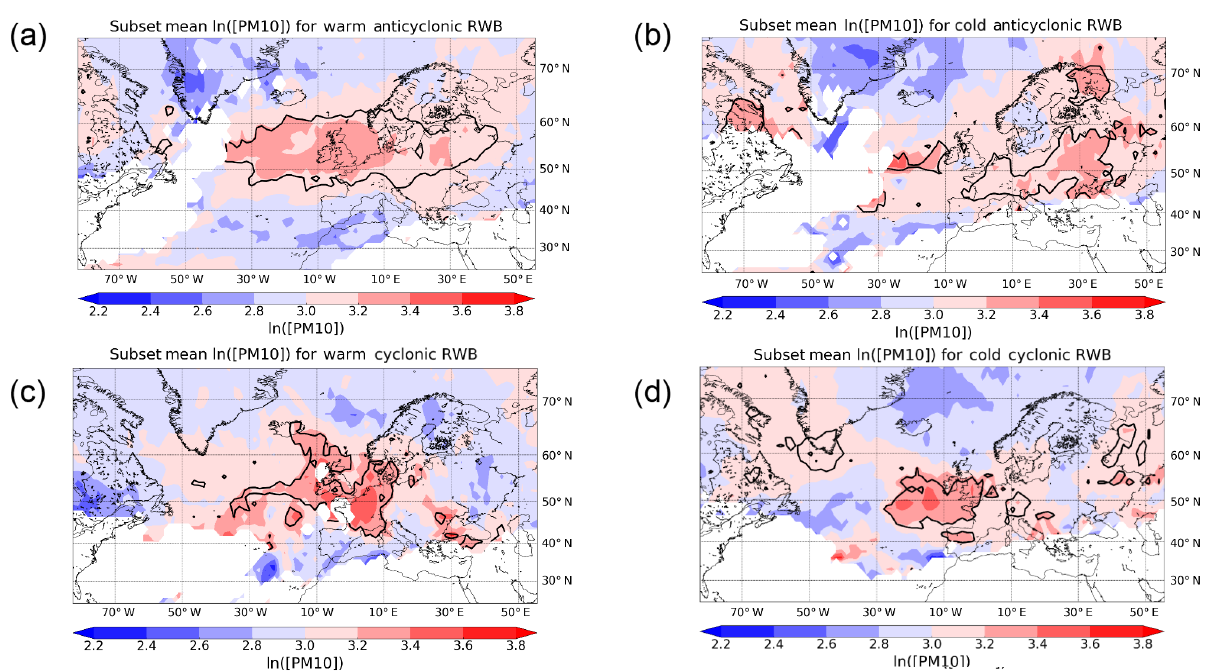
Figure 3. One-day lagged UK Midlands mean [PM 10 ] subset ( [ PM 10 ] Subset ) for each point within a gridded region for (a) warm anticyclonic, (b) cold anticyclonic, (c) warm cyclonic and (d) cold cyclonic Rossby wave breaking events. Solid (dashed) contours constrain regions where mean ln[PM 10 ] for each grid point is significantly greater (lower) than the entire dataset ln[PM 10 ] mean ( p < 0.01). White grid points represent points where RWB has occurred on less than two occasions throughout DJF January 1999–December 2008. Dataset mean [PM 10 ] = 21.69µgm − 3